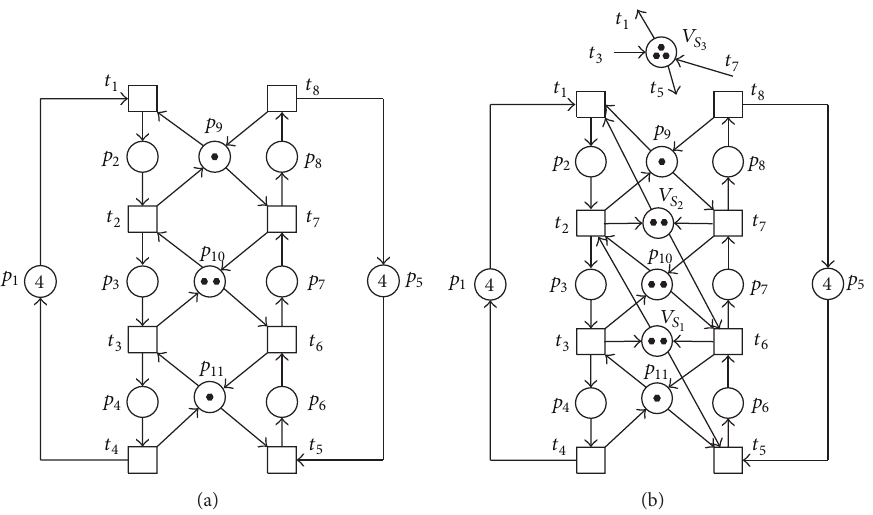
Figure 1: (a) An S 3 PR (𝑁,𝑀 0 ) and (b) a controlled system of 𝑁 .